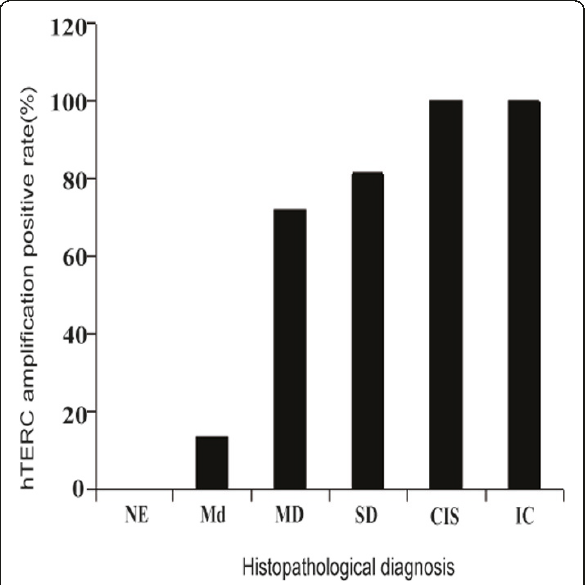
Figure 7 The increasing trend of hTERC amplification positive rates associated with the severity of laryngeal lesions, for histopathologic diagnosis